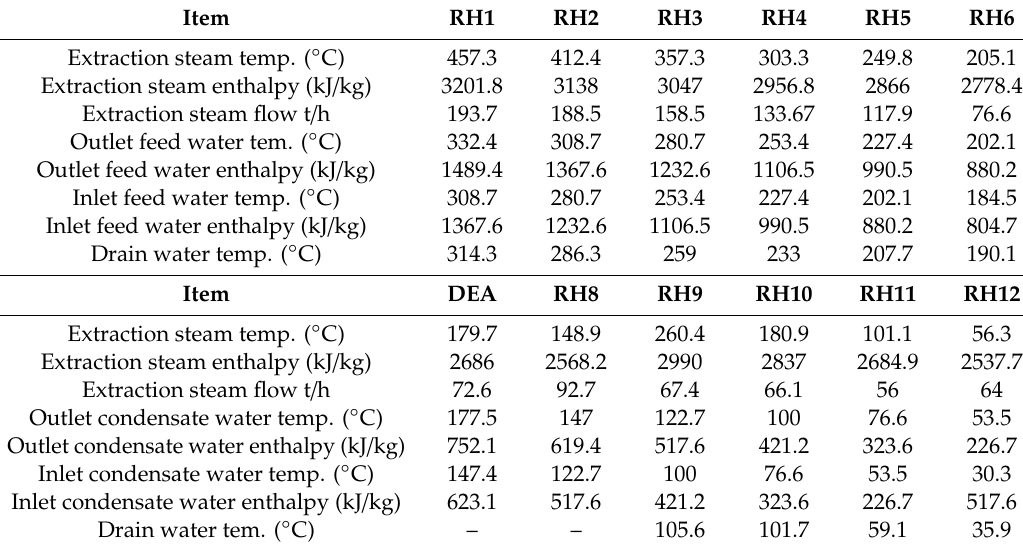
Table 2. Main parameters of regenerative heaters.